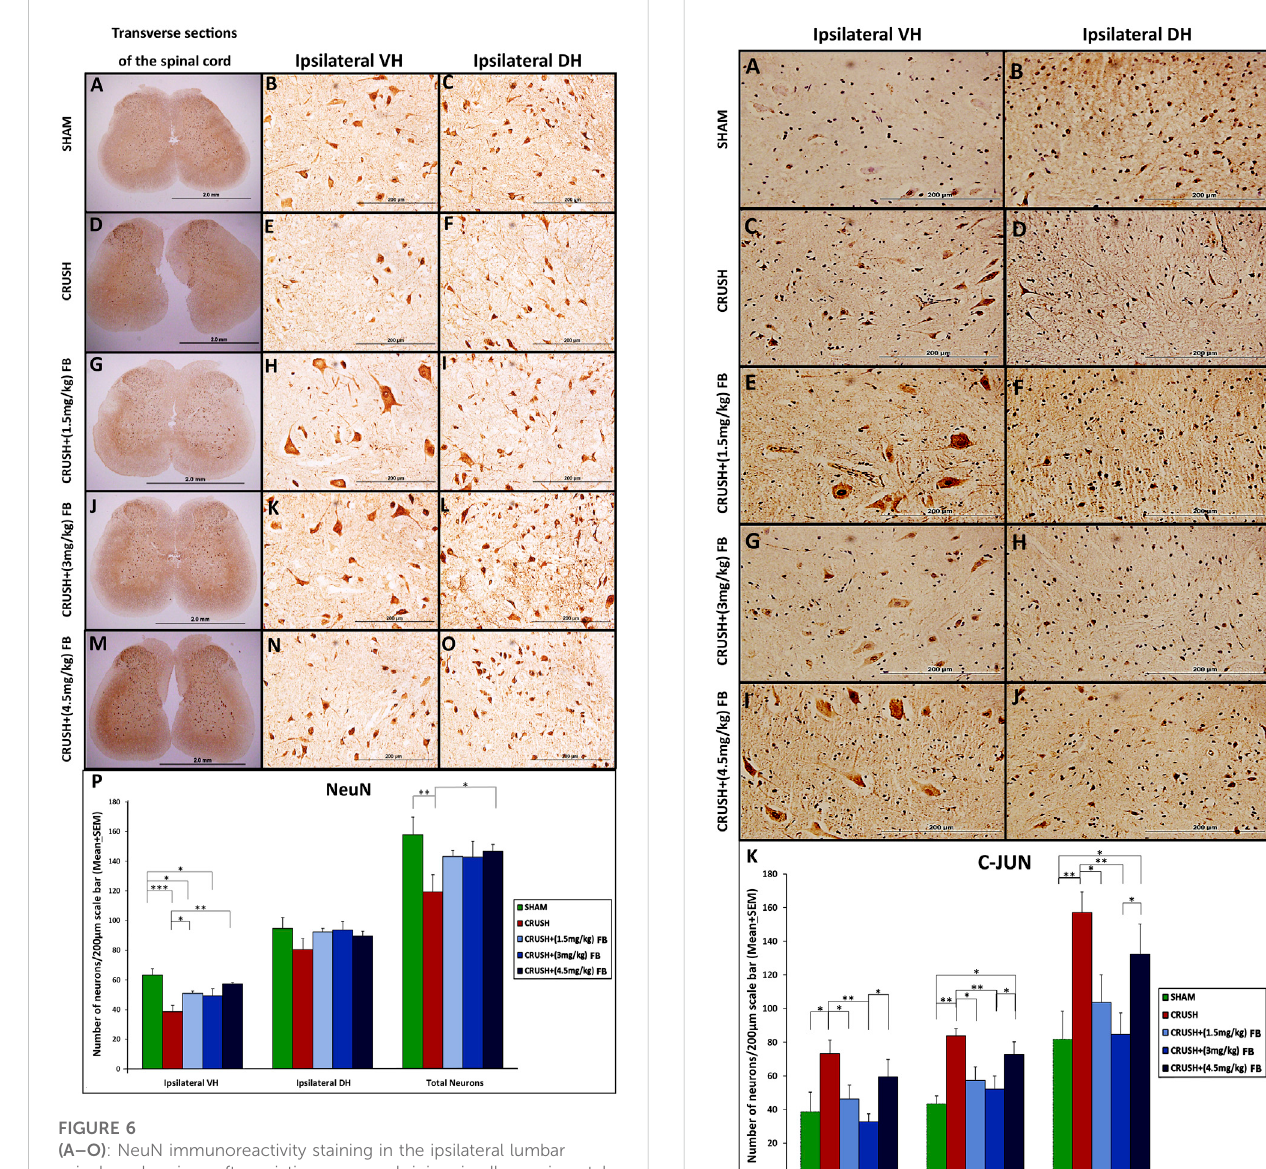
revealed that c-Jun in treated animals with (1.5 mg/kg) FB and